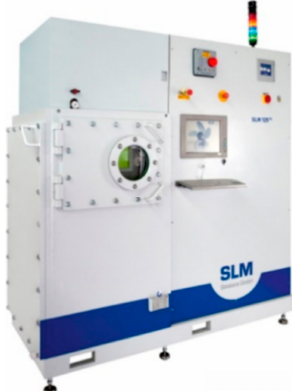
Figure 2. Modified SLM125HL system with overpressure chamber and build chamber reduction to 50 × 50 × 50 mm³.